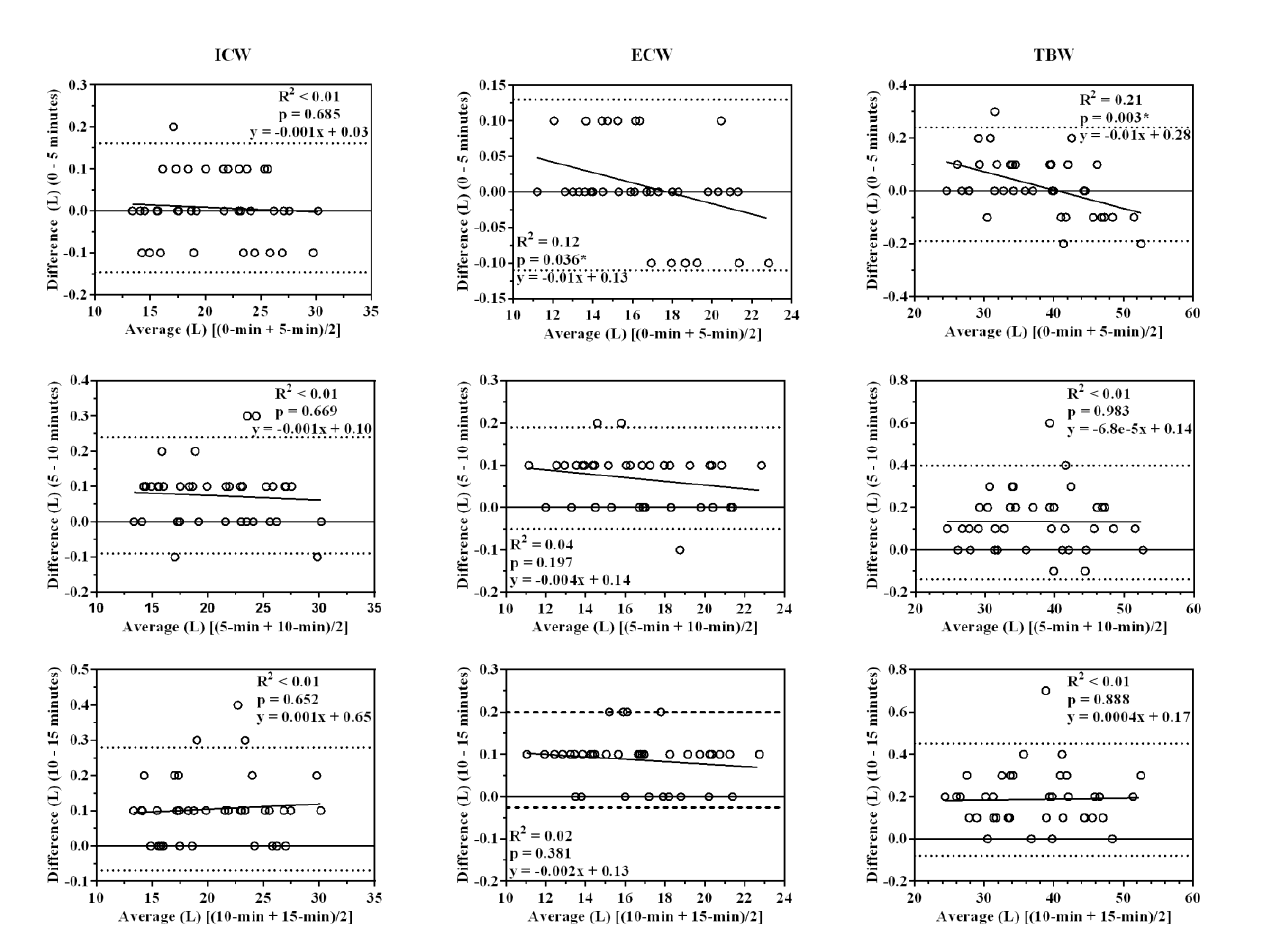
Fig. 5: Bland and Altman plots of individual differences for the effect of time since transitioning from a vertical to a supine position on intracellular water (ICW: left side), extracellular water (ECW: middle), and total body water (TBW: right side) (N = 38). The solid line represents a mean difference (bias) of zero. The dashed lines denote the upper and lower limits-of-agreement (bias ± [1.96×SD of the bias]). R 2 represents the amount of variance explained by the average ICW, ECW, or TBW. *p<0.05 significant systematic